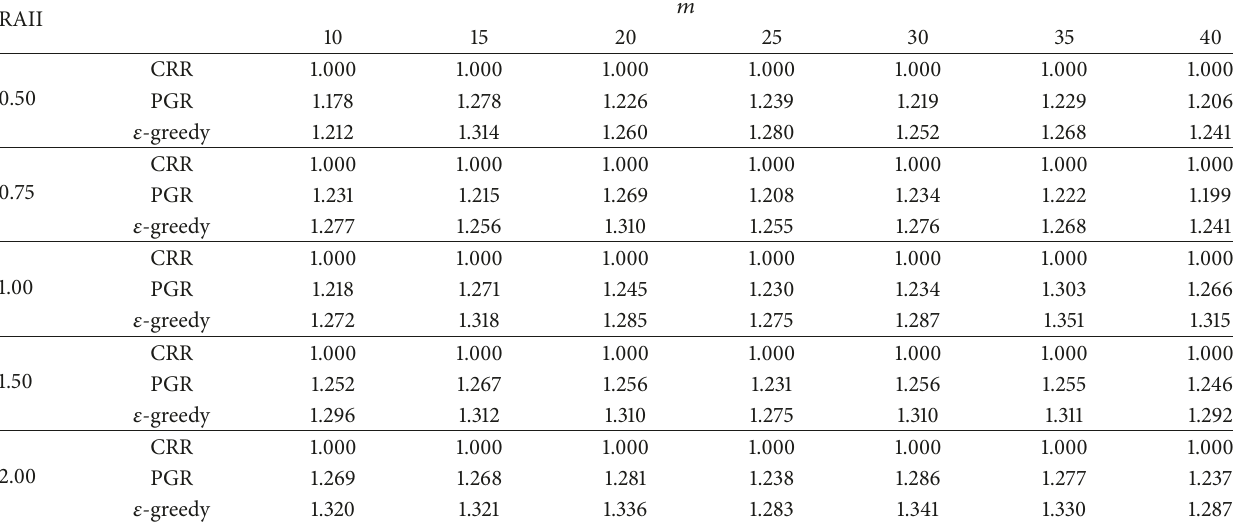
Table 2: The relative AWT value of the three